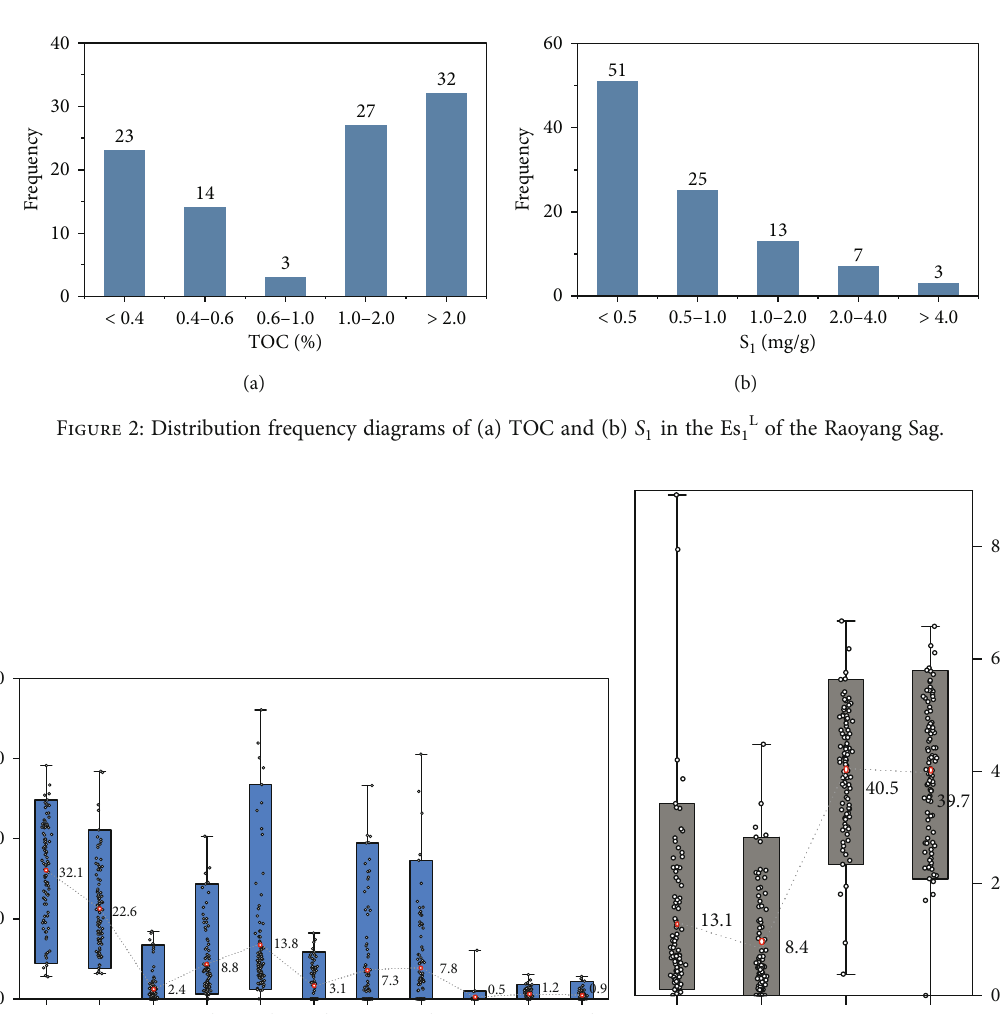
Figure 3: (a) Inorganic mineral and (b) clay mineral contents of Es 1L in the Raoyang Sag. CM: clay minerals; Qtz: quartz; PF: potash feldspar; PI: plagioclase; Cal: calcite; Dol: dolomite; Ara: aragonite; Gyp: gypsum; Py: pyrite; and Sid: siderite.